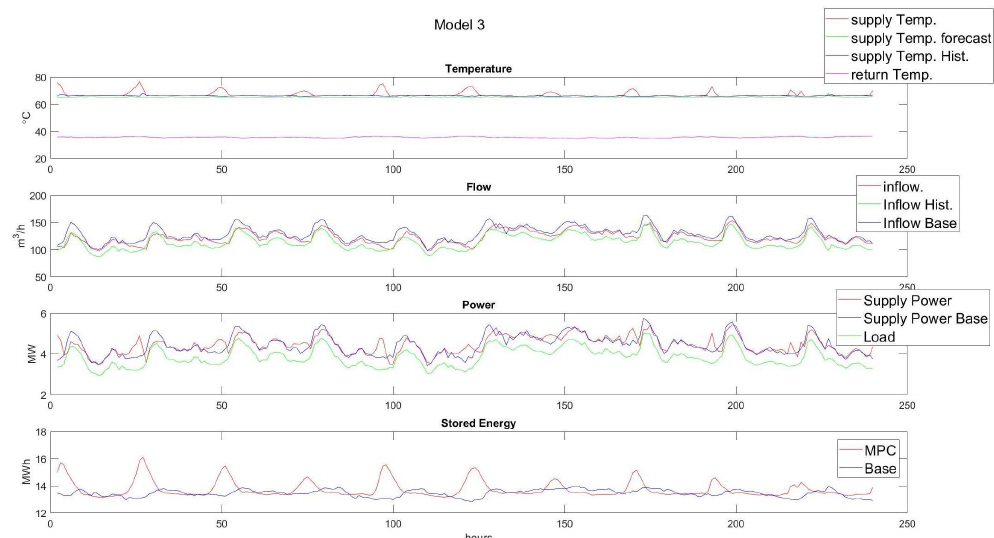
Figure 8. Performance results of model 3, showing peak shaving though also inducing large peaks. MPC results (red), base simulation (blue), and historic results (green).